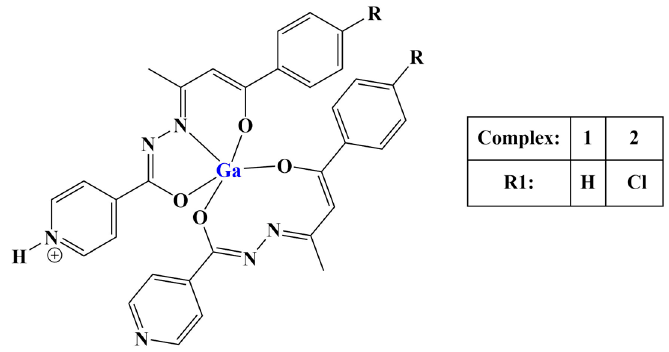
Figure 22. The complexes presented in [84].